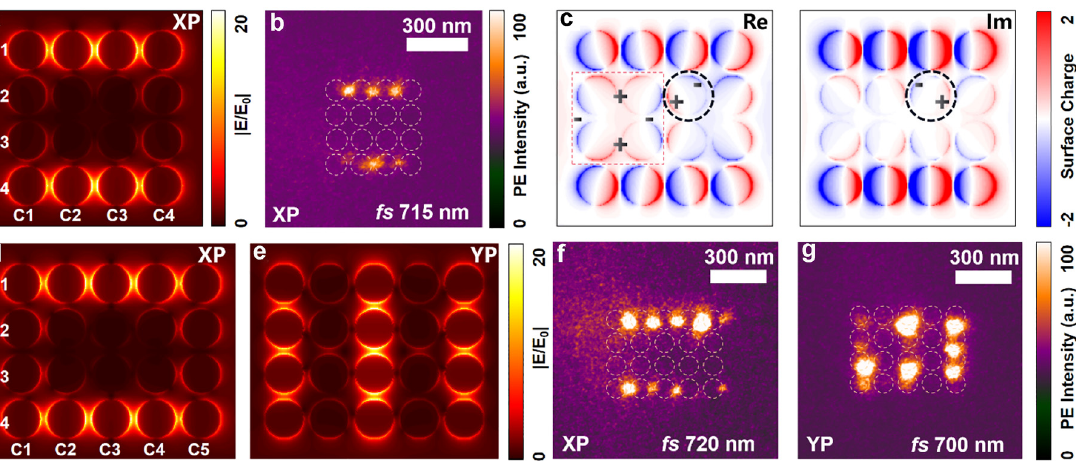
Figure 2: Near-field images of square-lattice simulated and experimental results. (a) Simulated electric field distribution of C4R4 meta-arrays under XP excitation. The columns and rows are number by C1 to C4 and R1 to R4. (b) The experimental near-field image of the edge state in C4R4 meta-arrays under XP excitation. The field of view is 5 um and the excitation wavelength is 715 nm. (c) Simulated real and imaginary parts of surface charge distributions of edge state for C4R4 meta-arrays under XP incidence. The dashed red rectangle marks the large quadrupole mode excitation of the four interior disks. The dashed black circles show the dipole-mode direction is not completely parallel to the polarization direction. (d, e) Simulated electric field distributions under XP and YP excitation for C5R4 arrays. (f, g). Corresponding experimental near-field imaging of edge state and bulk state under XP and YP excitation. The field of view is 5 um and the excitation wavelength is 720 nm and 700 nm,